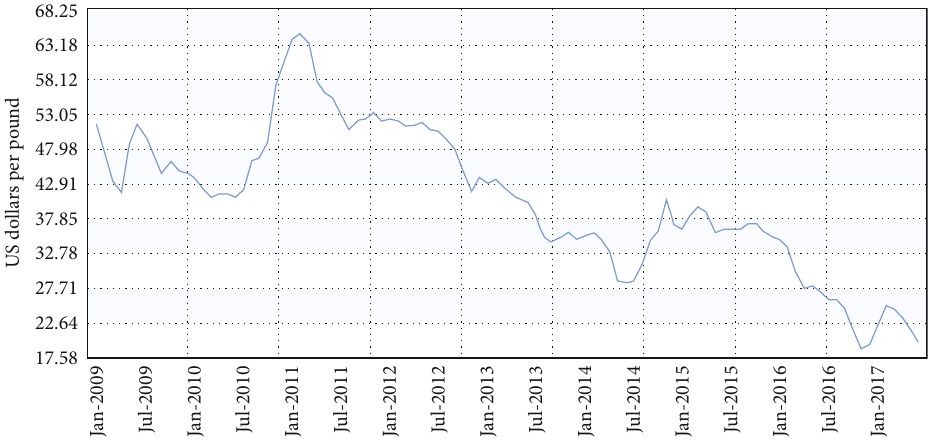
Figure 10: Historical nuclear fuel chart.